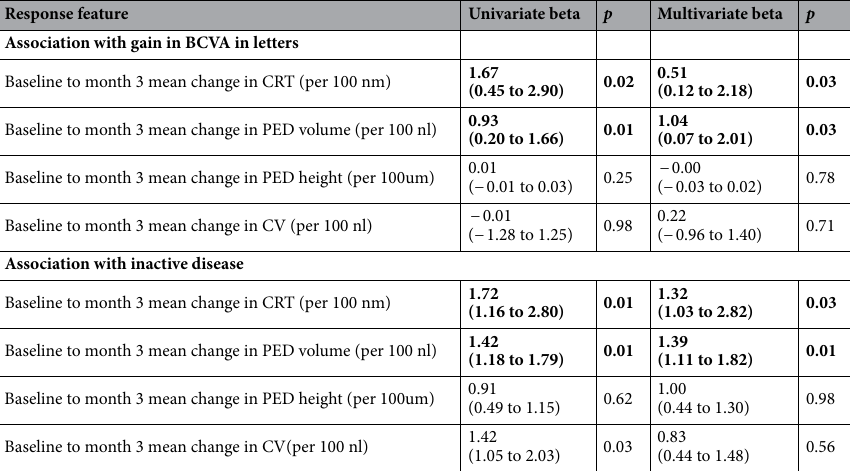
Table 4. Association of treatment outcomes at month 3 with outcomes at month 12. CRT central retinal thickness, PED pigment epithelium detachment, CV choroidal volume; Multivariate analysis adjusted for age, sex and number of injections. Bold fonts denotes parameters significantly influencing the gain in BCVA and disease activity at month 12 from baseline and are retained in the final multivariable